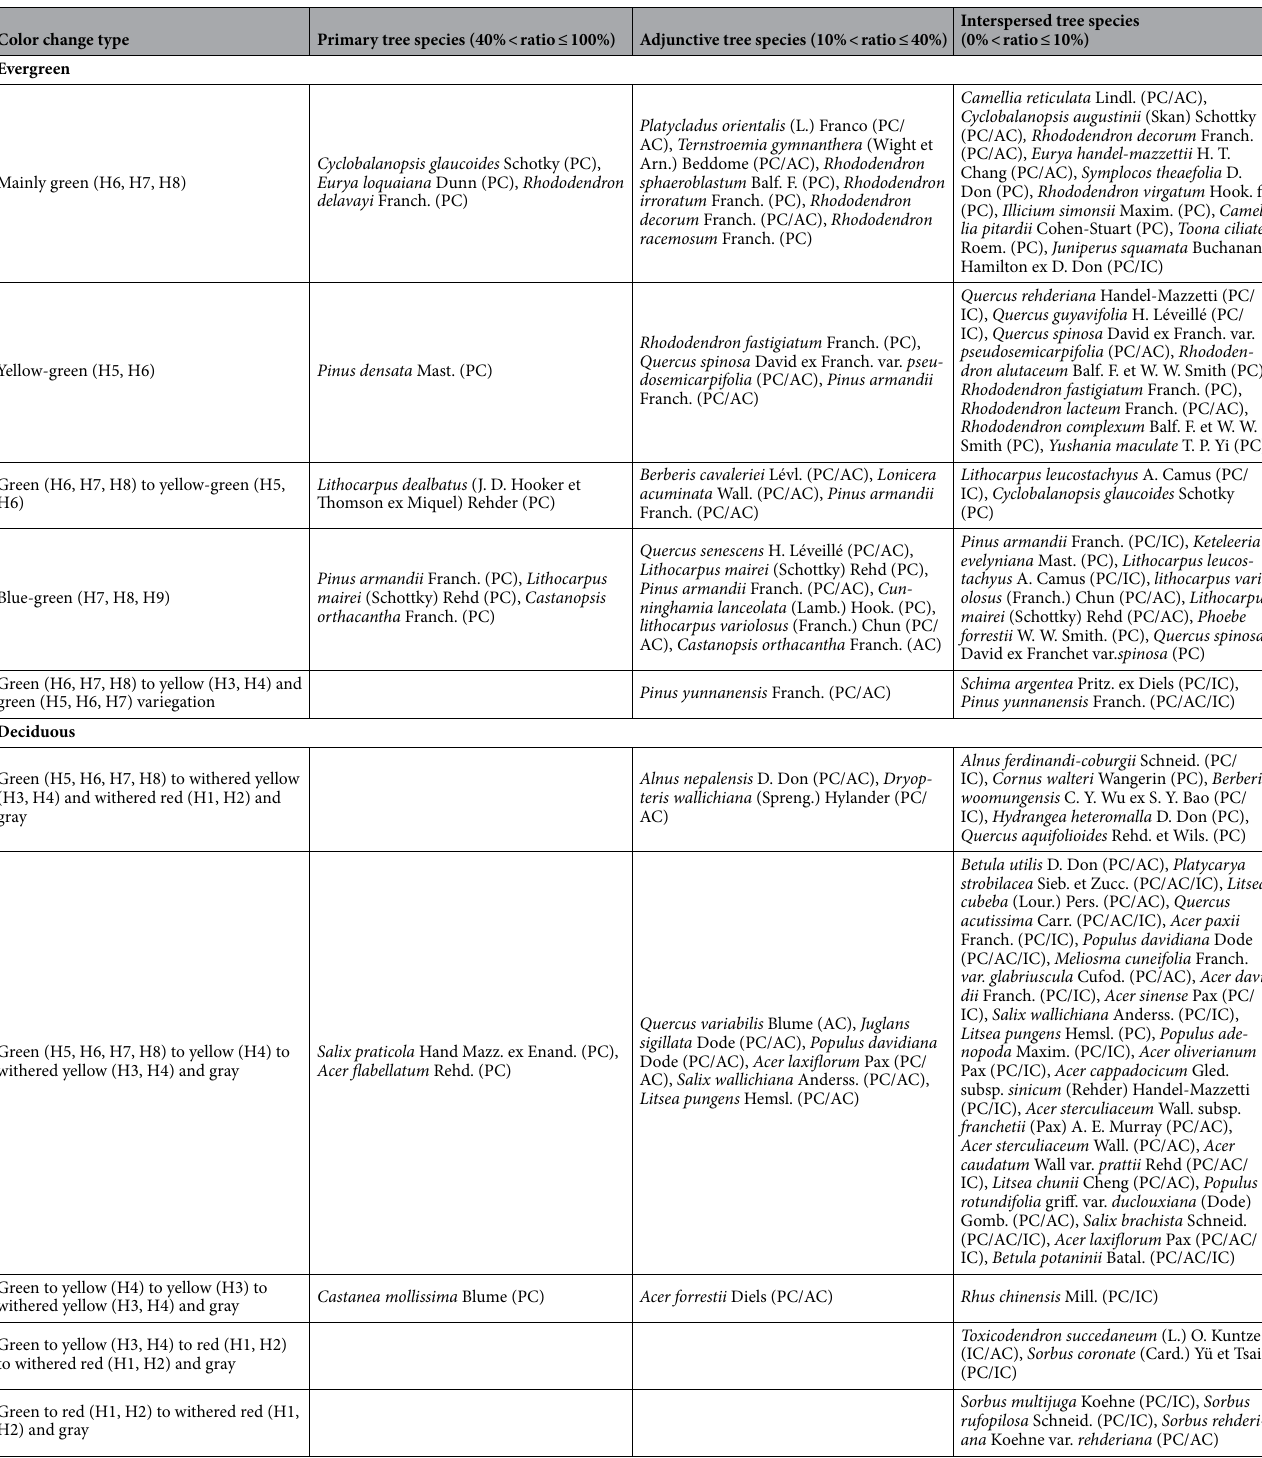
Table 4. Classification of the characteristics of color change of tree species. PC primary color, AC adjunctive color, IC interspersed